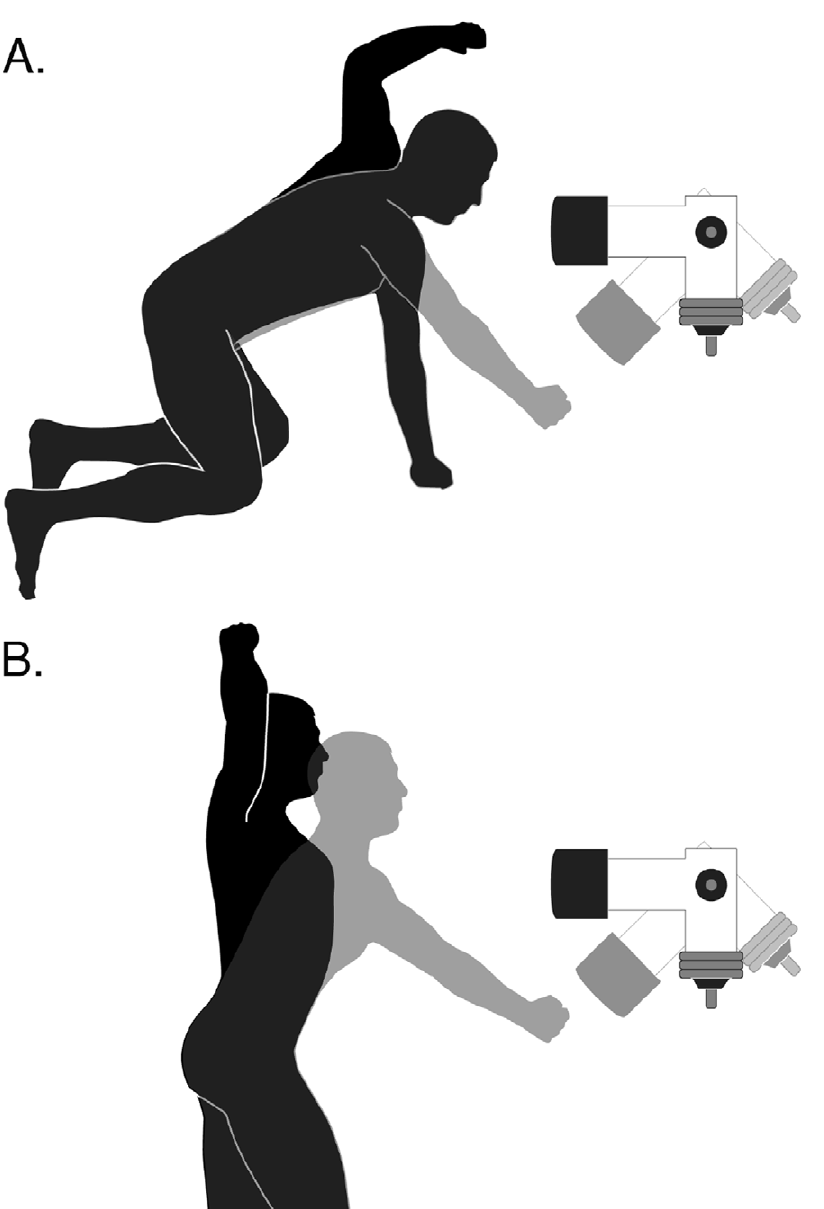
Figure 2. Illustrations of the pendulum transducer used to measure the energy imparted during maximum effort vertically directed strikes from (A) quadrupedal and (B) bipedal posture. The starting posture of the subject and position of the transducer are shown in black. Body posture and the swing of the transducer after the strike are illustrated with grey.